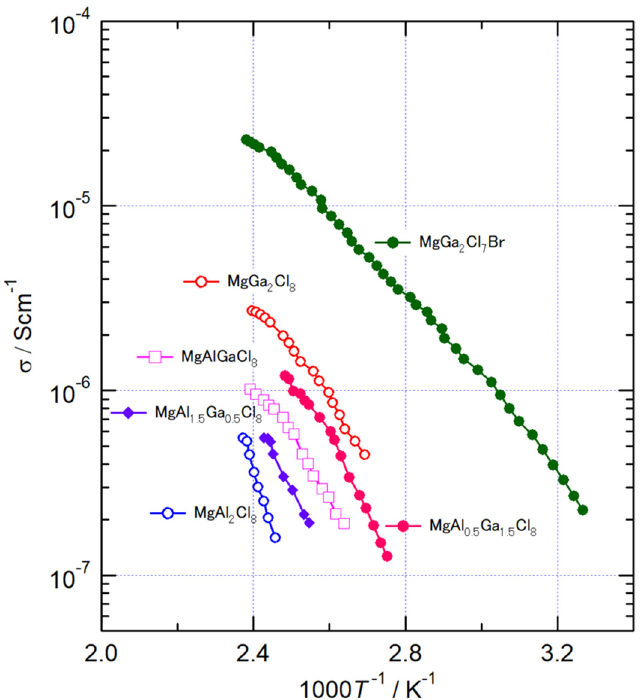
Figure 3. Temperature dependence of AC conductivity of MgAl 2-x Ga x Cl 8 and MgGa 2 Cl 7 Br.